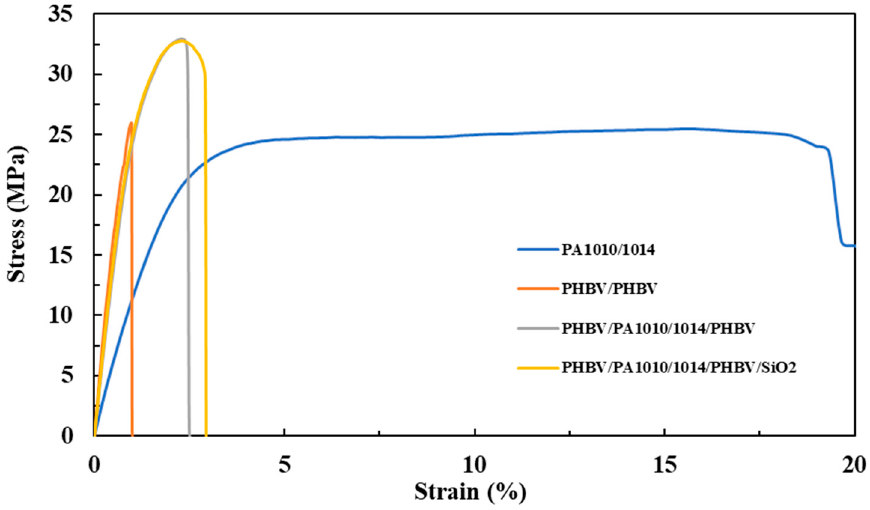
Figure 7. Typical tensile stress–strain curves of the annealed electrospun films of: PHBV bilayer; PA1010/1014 monolayer; PHBV/PA1010/1014/PHBV multilayer; and PHBV/PA1010/1014/PHBV/SiO 2 multilayer.